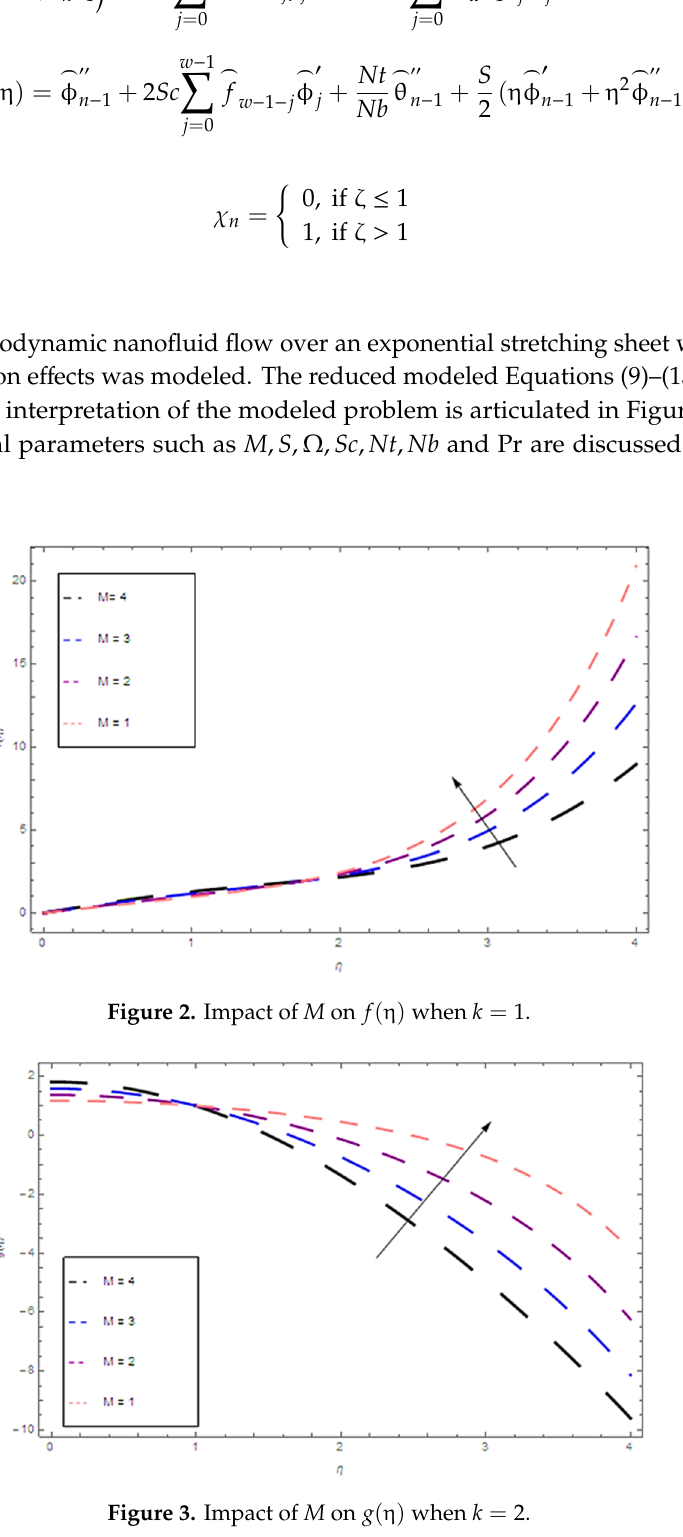
Figure 3. Impact of M on g ( η ) when k = 2 .